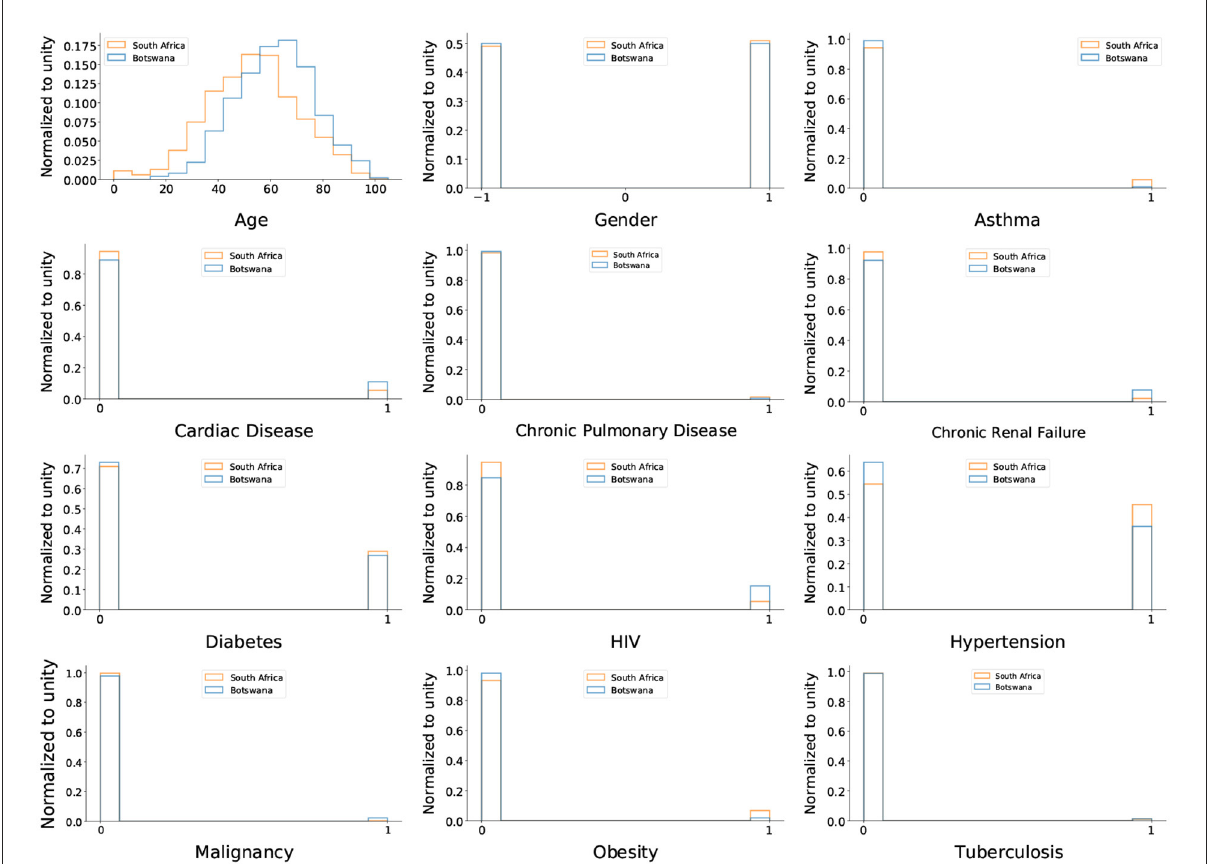
FIGURE10 The distributions of the input variables are used to train the DNN. The blue histogram represents Botswana data, while the orange histogram represents South African data. For histograms related to comorbidities, the peak at zero denotes patients who do not have a comorbidity, while the peak at one denotes patients with comorbidity.